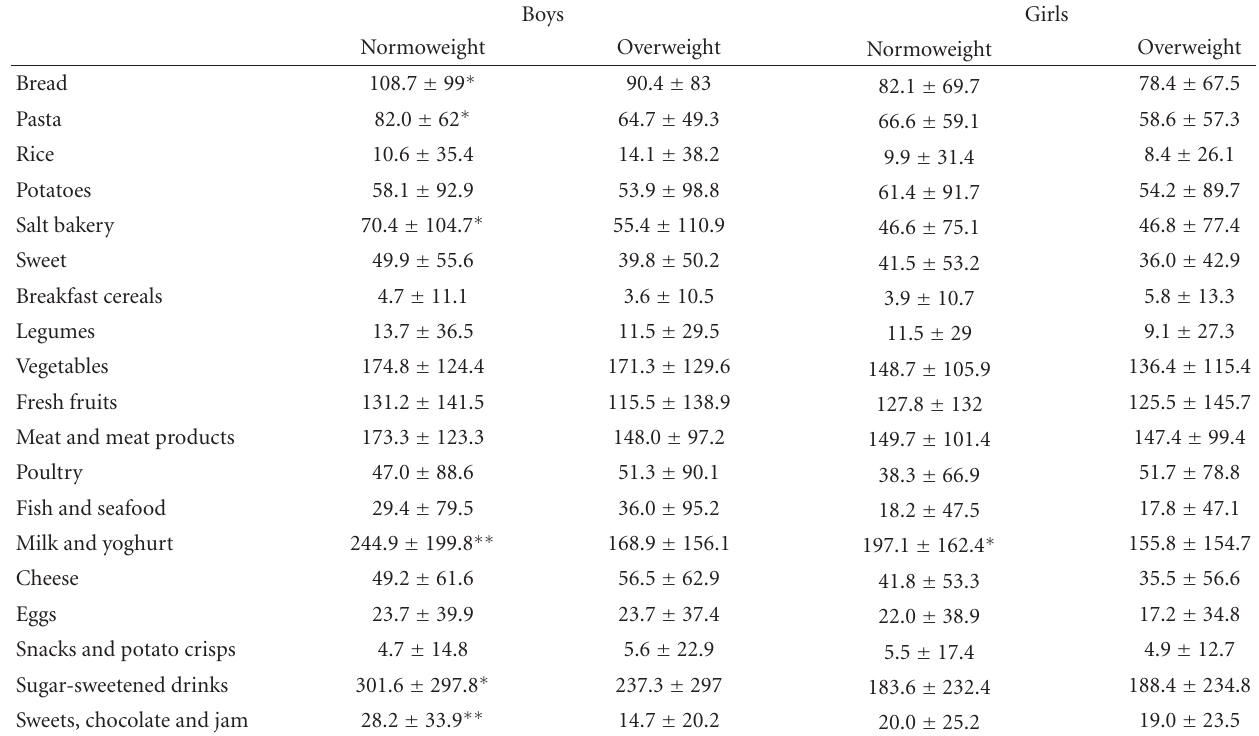
Table 3: Consumption of food categories (g/day/per capita, mean ±